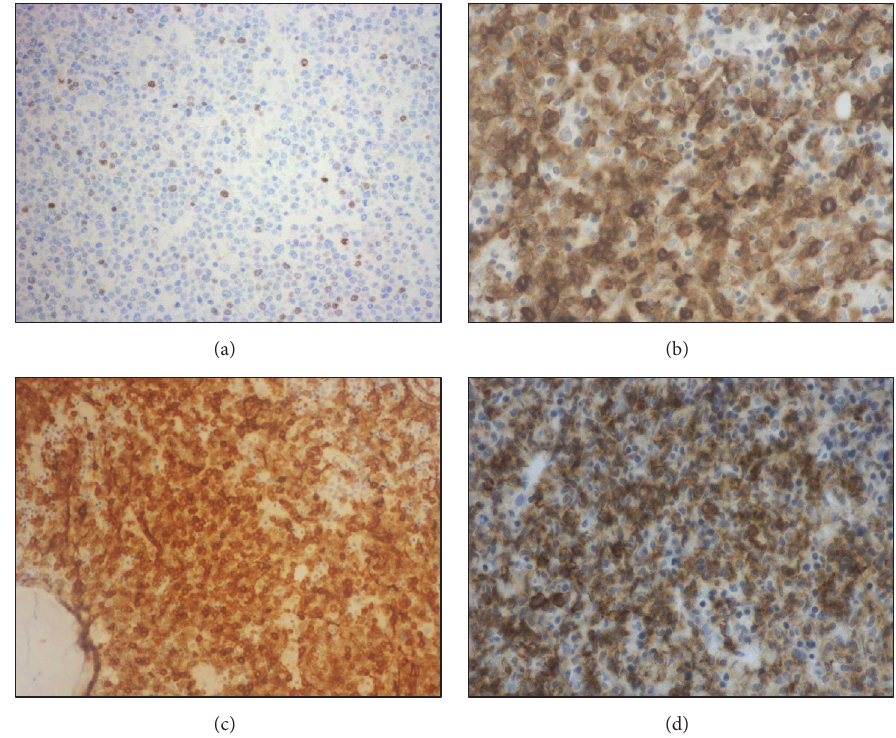
Figure 4: Lymph node immunohistochemistry analysis: immunostaining for TdT showing partial positivity (a); CD4 positive immunostain- ing (b); CD10 immunostaining on cell surface (c); CD56 positive immunostaining